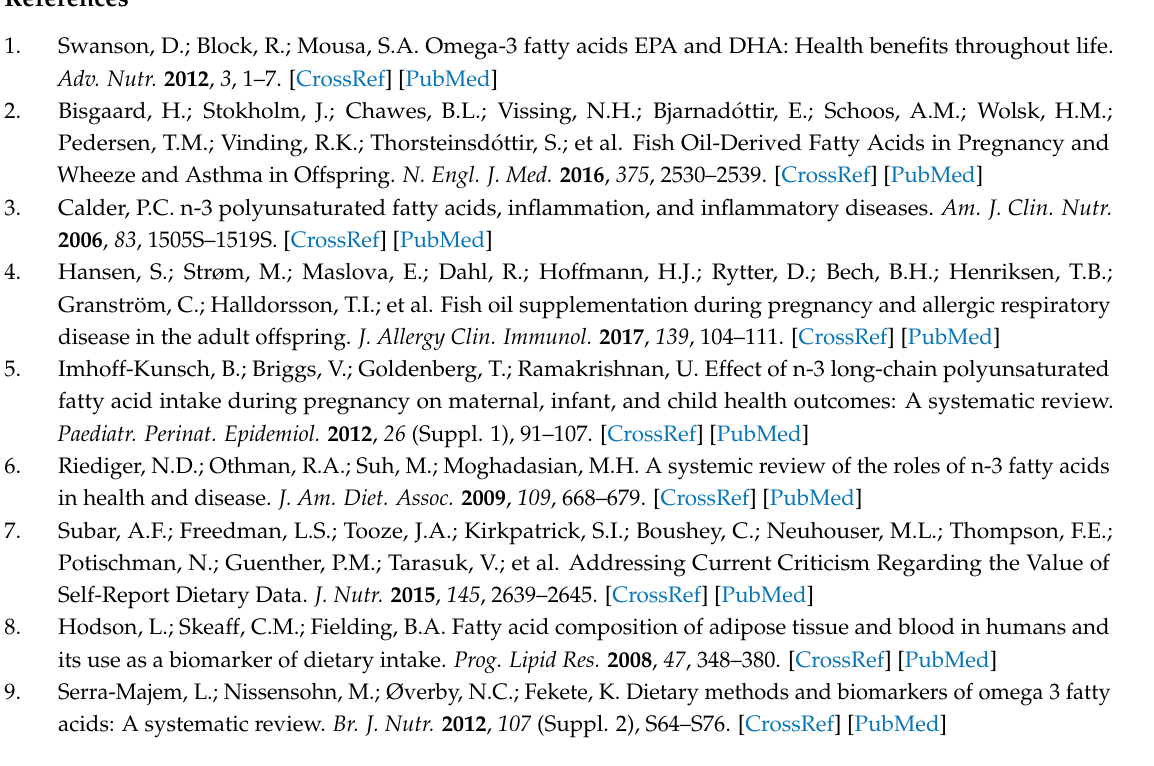
Figure S1: Quartile mean intake of EPA+DHA (g/day) and the corresponding plasma concentration of EPA+DHA (% TFA) ( n = 255). Table S1: Difference in biomarker concentration (%TPFA) per 1 percentage increase in relative fatty acid intake and correlations between biomarker concentration and intake from Spearman statistics unless indicated otherwise ( n = 255). Table S2a: Difference in biomarker concentration (%TFPA) per increase in daily intake and correlations between biomarker concentration and intake from Spearman statistics unless indicated otherwise. Stratified to samples stored at − 196 ◦ C since 2013 ( n = 203). Table S2b: Plasma sample storage temperatures ( n =